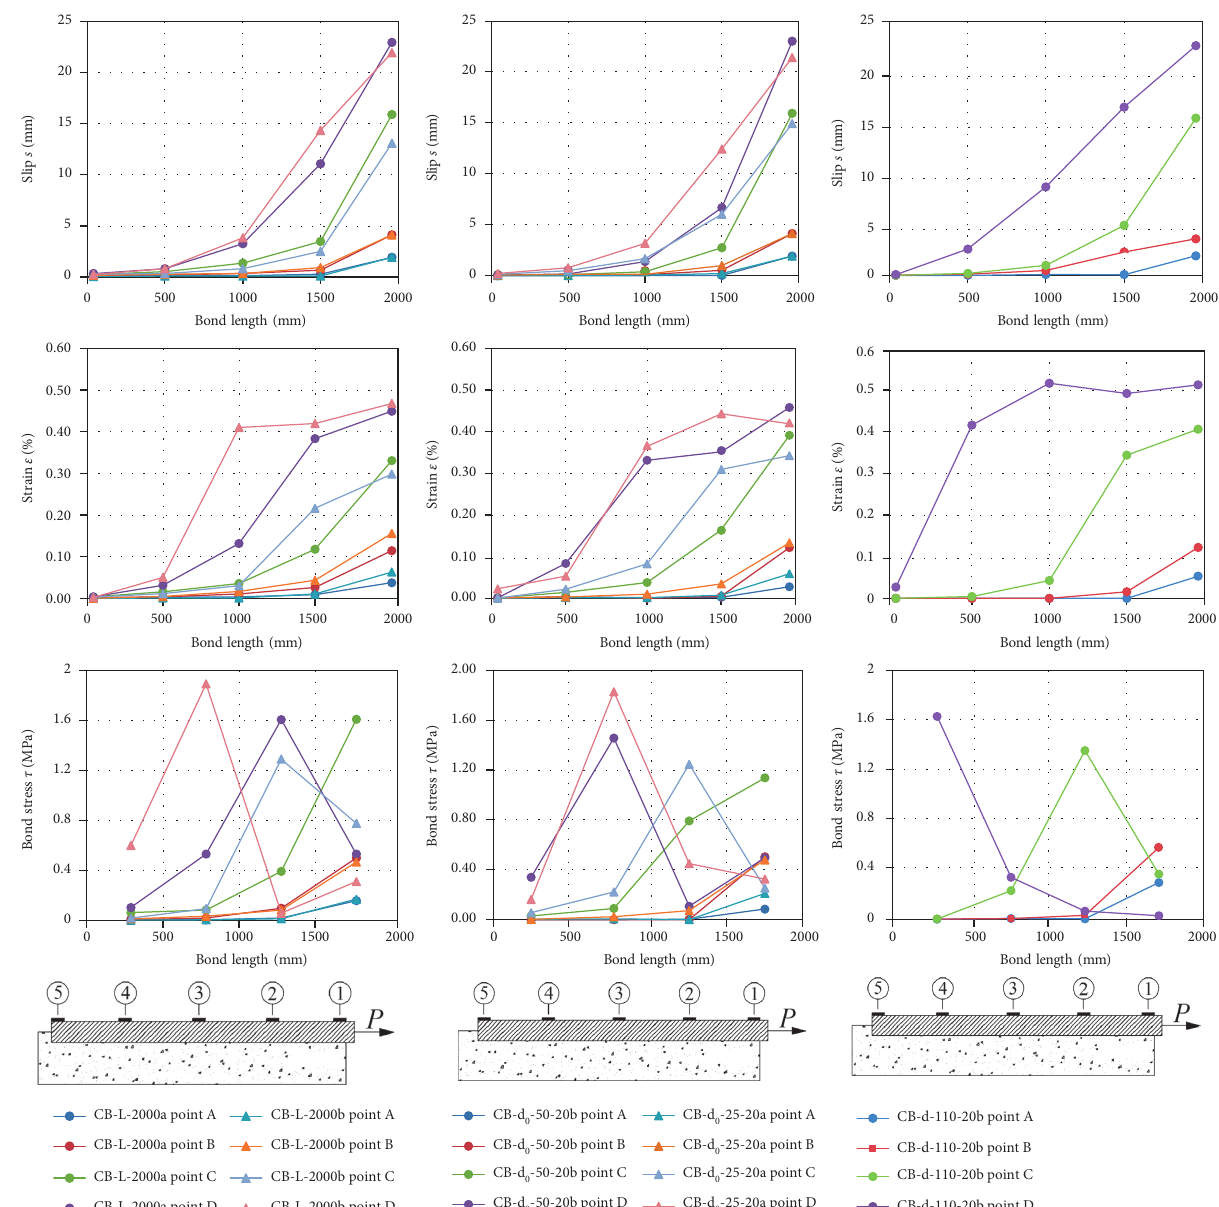
Figure 15: Stress, strain, and slip distribution of the bonding interface in the axial direction of the long bolt ( L ≥ L